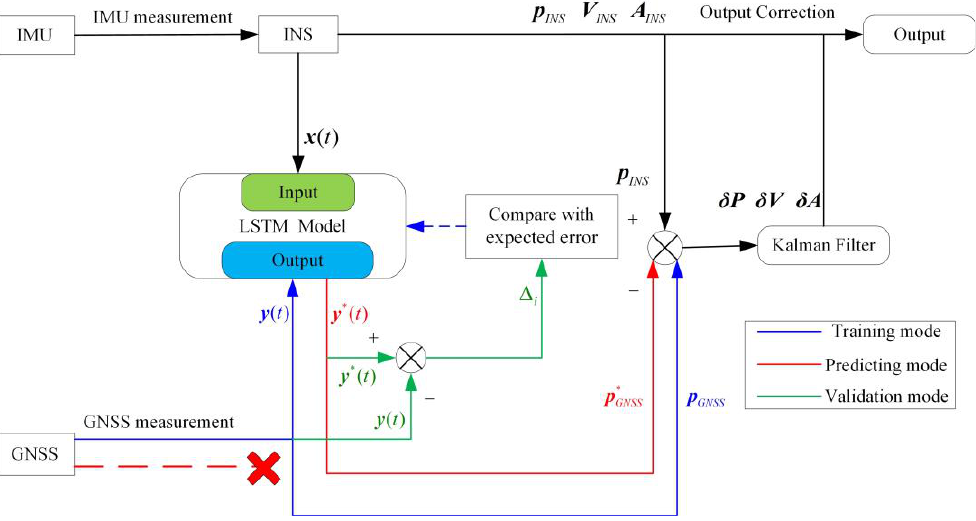
Figure 2. Structure Diagram of Loose Coupling Navigation Scheme with Intelligent Virtual Sensor.